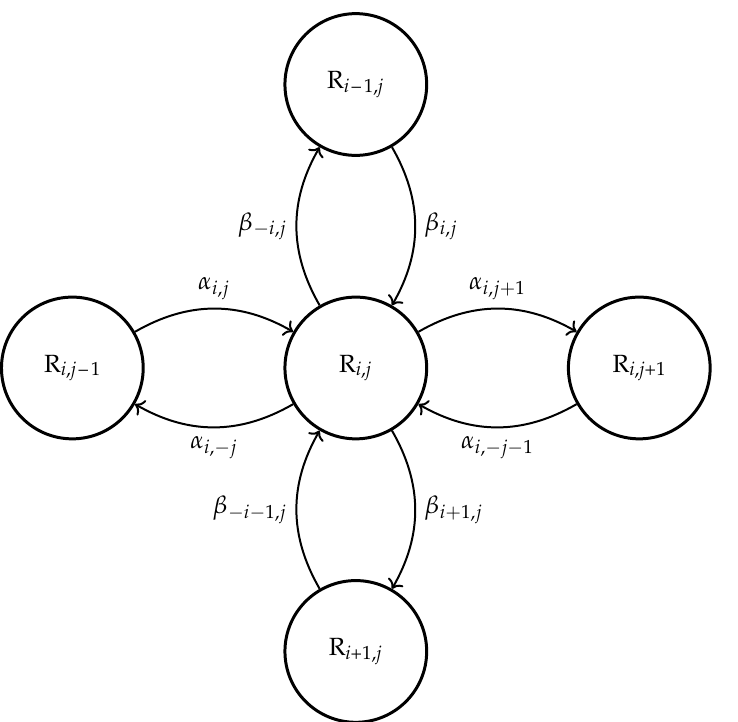
Figure 1. Flowchart of enzymatic reactions with the respect to EIS-complex R i , j